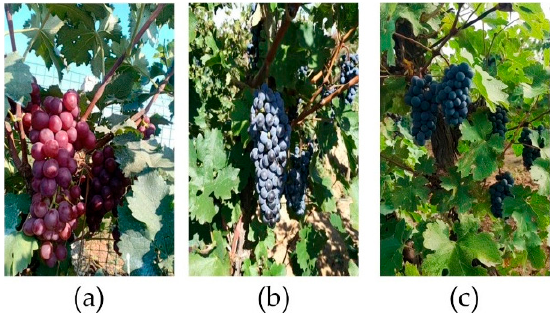
Figure 3. Distortion of colors and shapes under shadow or occlusion: ( a ) Grape color distortion in shadow; ( b ) Different color of grapes in the sun and in the shadow; ( c ) Obstructed grape shape distortion.